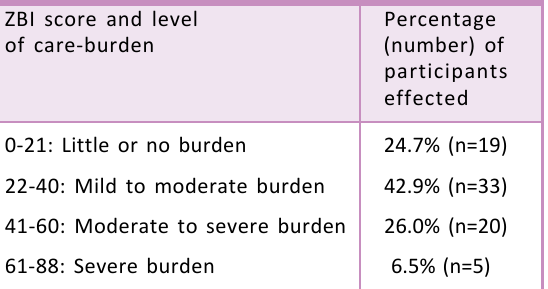
Table 1. Levels of care-burden experienced by